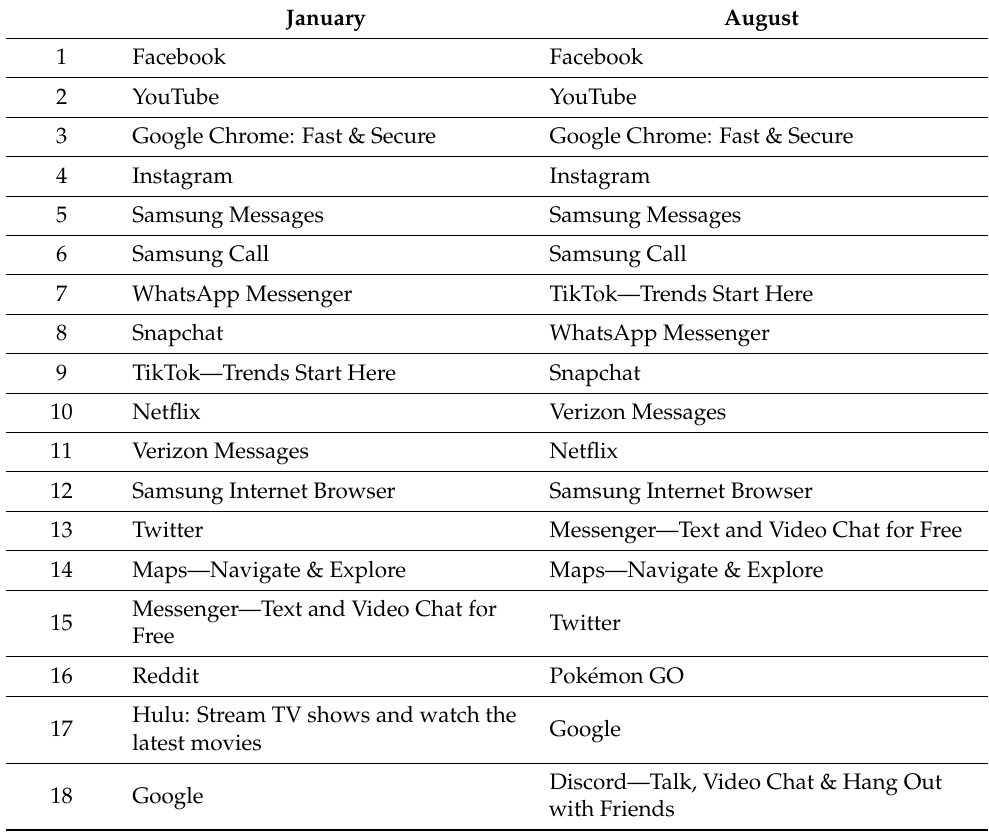
Table 1. Top 100 applications in January and August